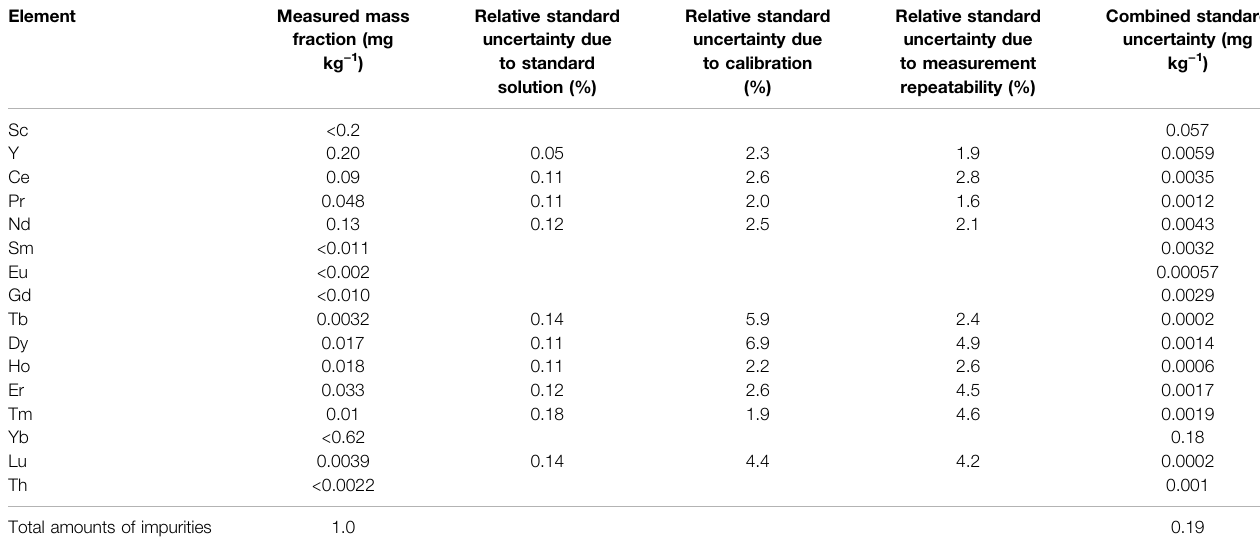
TABLE 3 | Analytical results of impurities in the original La 2 O 3 sample.